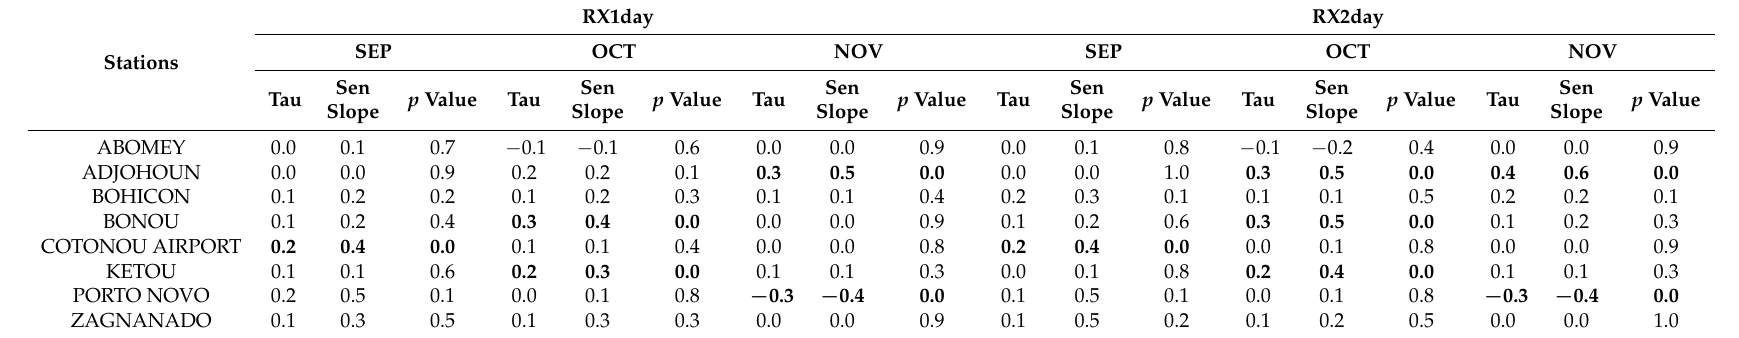
Table 7. Monthly trend analysis of one-day precipitation amount (RX1day) and two-day precipitation amount (RX2day) during high water.